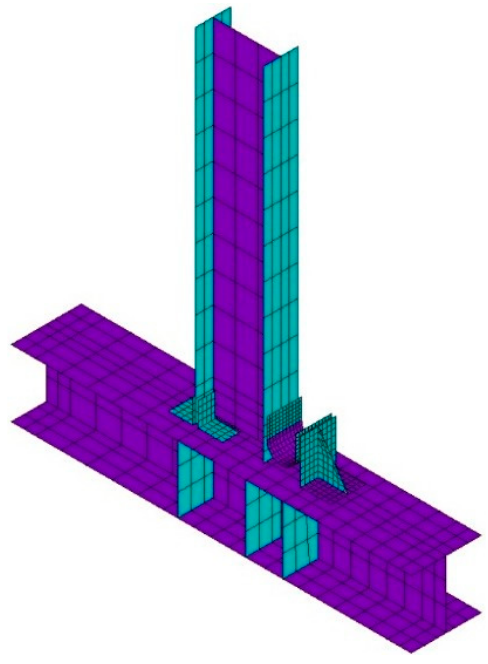
Figure 13. Finite element model.